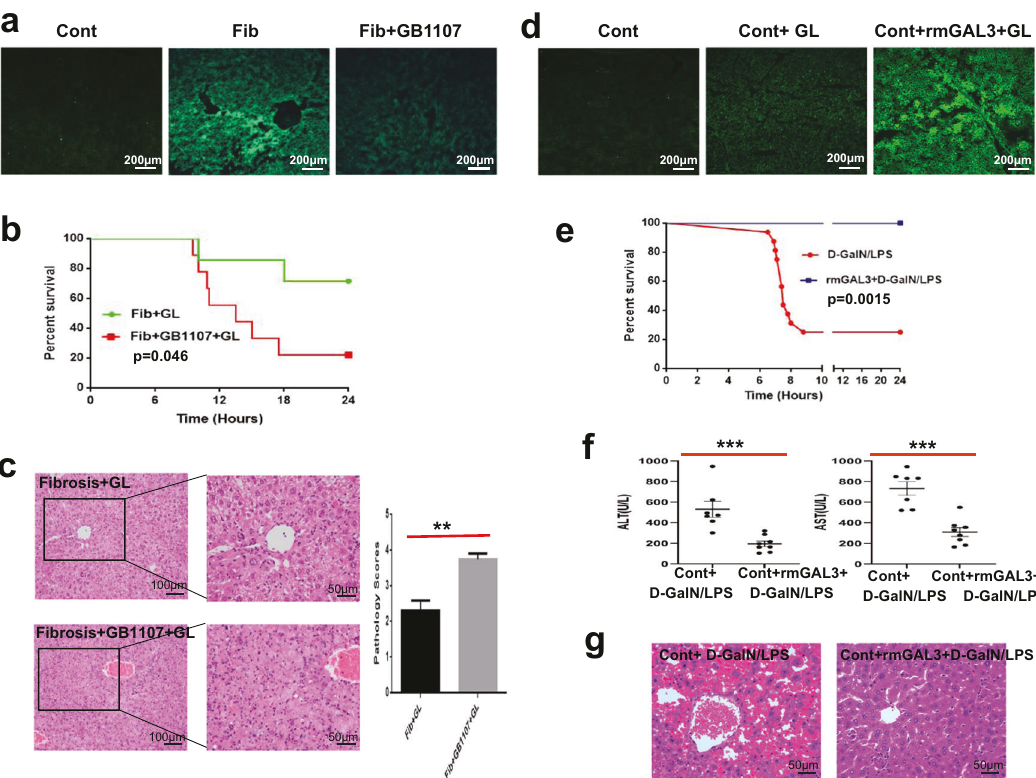
Fig. 2 GAL3 exerts bene fi cial hepatoprotection against acute insult in control and fi brotic mice. a The expression of GAL3 detected by IF staining in fi brotic livers with or without GB1107 treatment. b Comparison of the survival rate in fi brotic mice upon insult with or without GB1107 treatment ( n = 7 – 9). Survival analysis was conducted with the Kaplan – Meier method, and the log-rank test was used to compare the differences in survival between treatment groups. c Hepatic histology and pathology scores in fi brotic mice upon insult with or